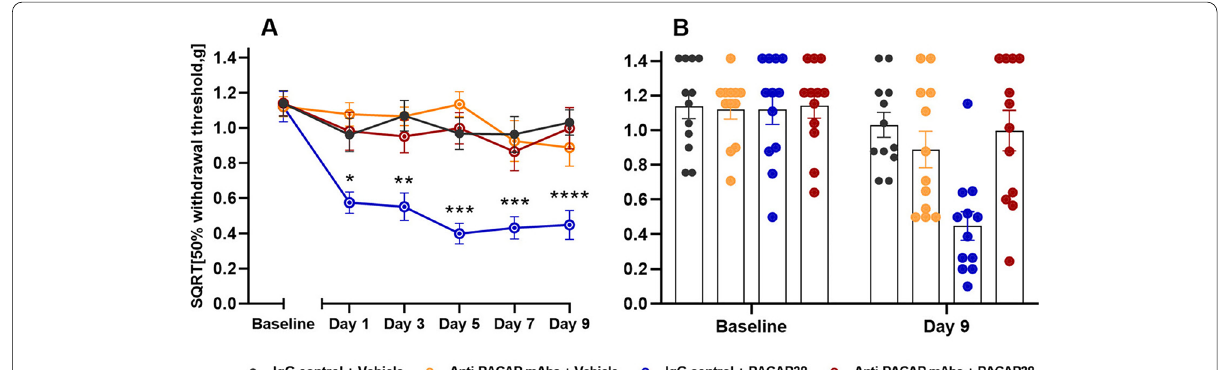
Fig. 2 Anti‑PACAP antibody block PACAP38‑induced hypersensitivity. Data are shown as square root transformed (SQRT) 50% withdrawal threshold (g). A Responses one hour after PACAP38 (2 µg/kg, s.c.) or vehicle injection (s.c.) in wildtype mice ( n pre‑treated with anti‑PACAP antibody or IgG control (30 mg/kg, i.p.) on day 0. Two‑way ANOVA with Tukey’s post hoc test for multiple comparisons